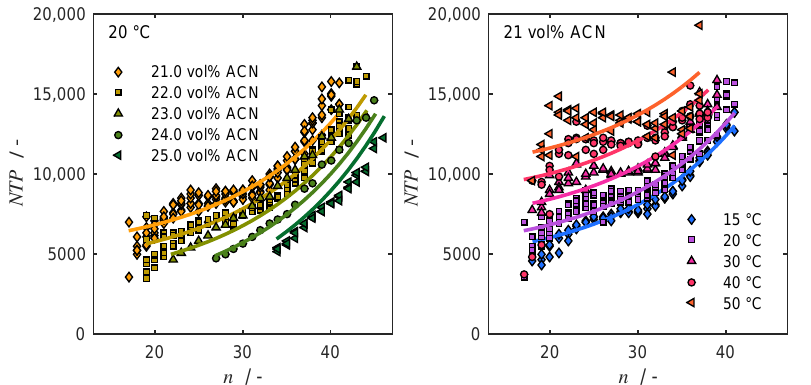
Figure 7. Dependence of NTP on polymerization degree, temperature, and acetonitrile content for PEG1400. Left — NTP values of the individual homologs at 20 ◦ C for different ACN levels. Right — NTP values at 21vol % ACN for different temperatures. Evaluated were all chromatograms for PEG1400; mutiple values for the homologs due to repetitive